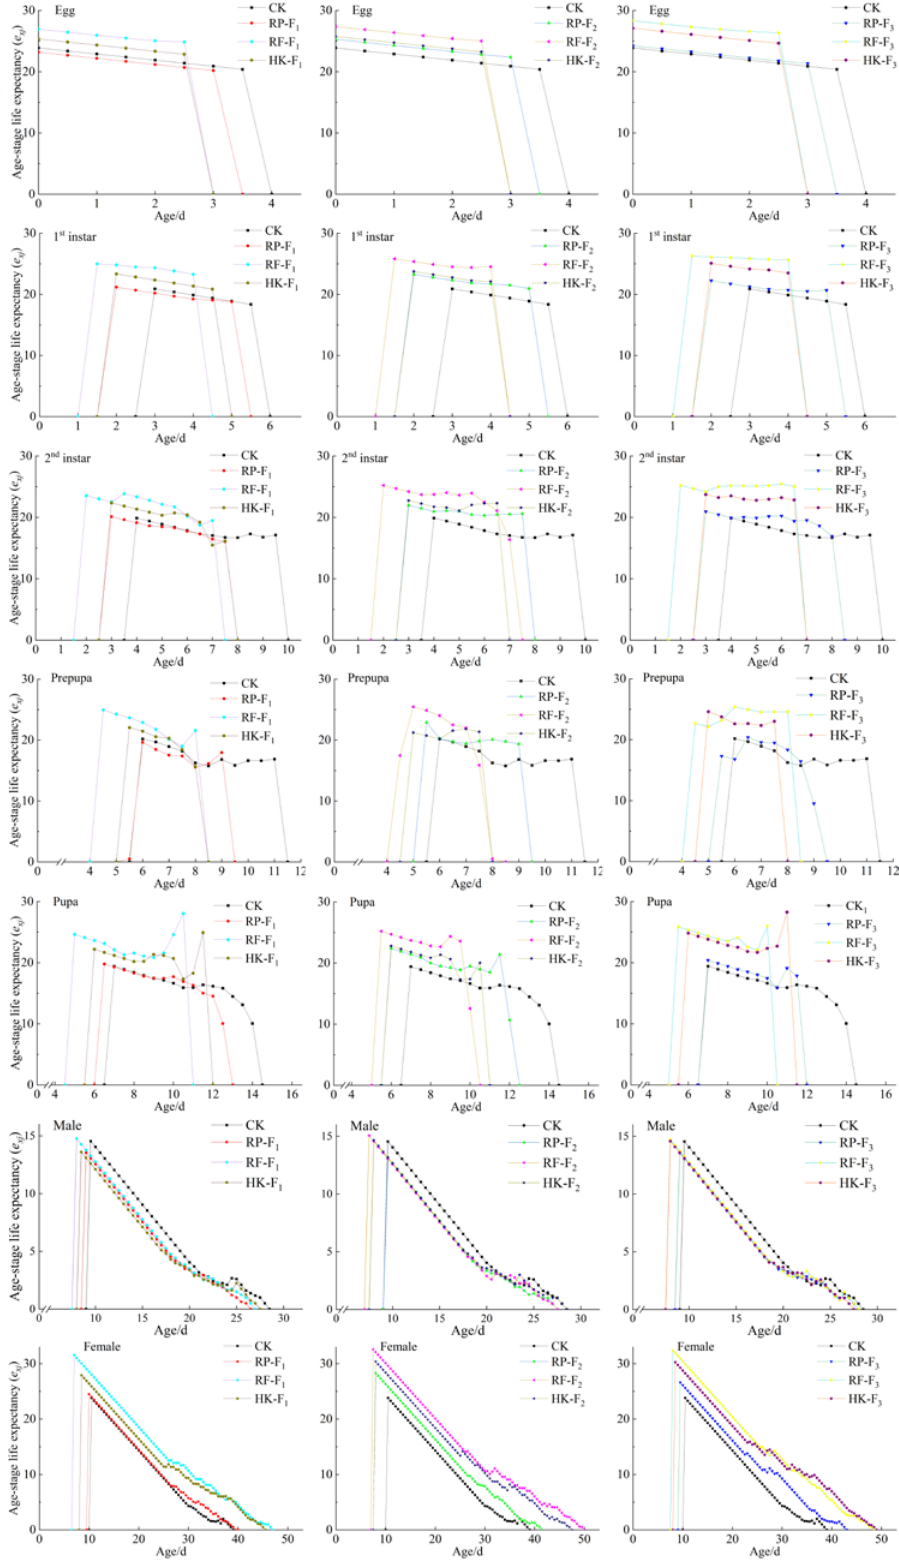
Figure 3. Age-stage life expectancy ( e xj ) of F. occidentalis on different food types in F 1 , F 2 , and F 3